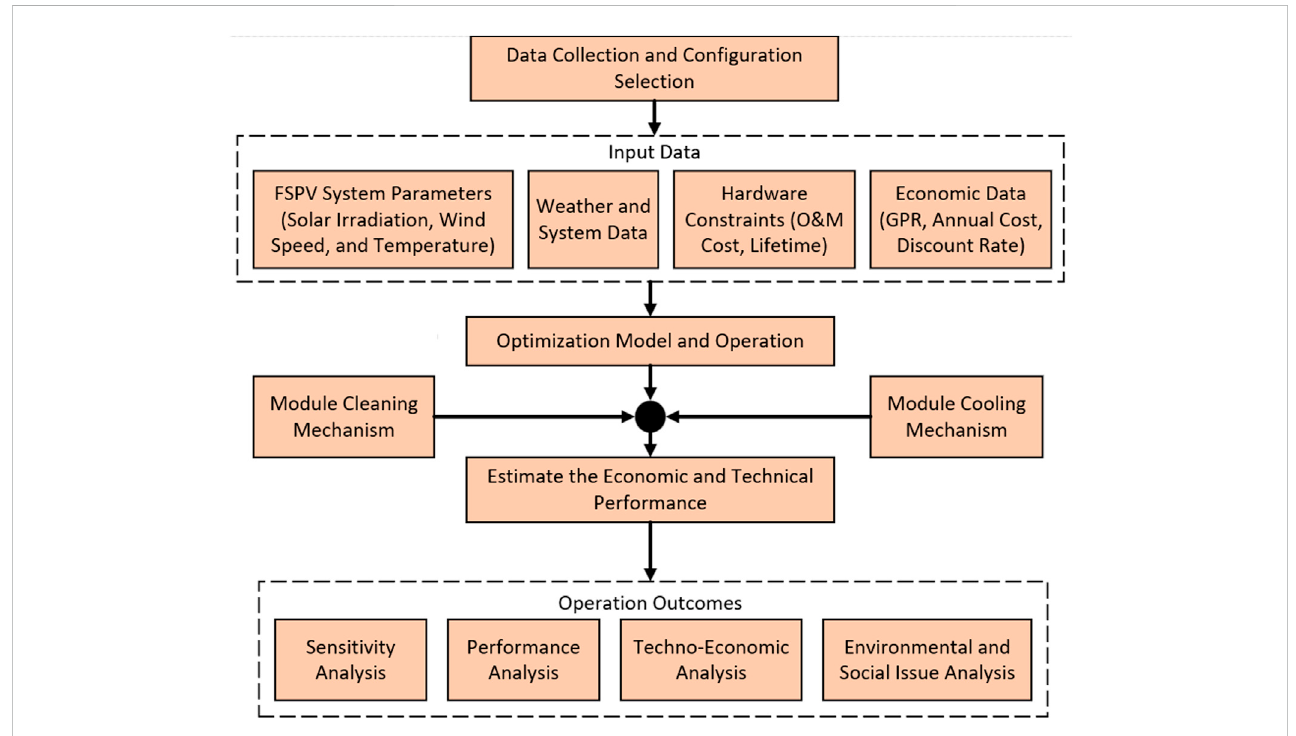
FIGURE 6 A holistic framework proposed for FSPV feasibility assessment considering techno-economic-environmental and social